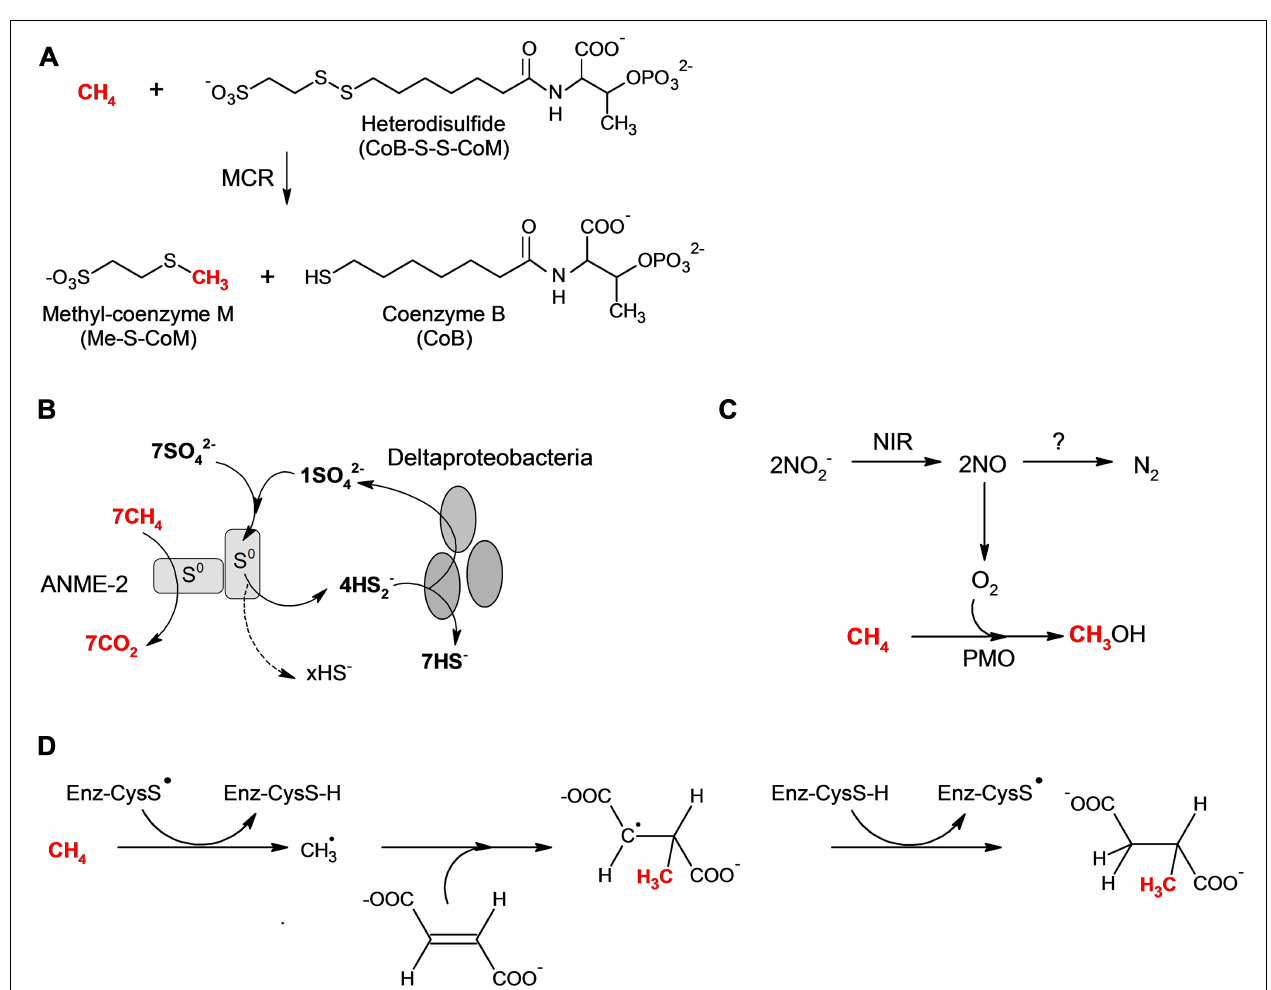
2010); and (D) Methane addition to fumarate (adapted from Beasley and Nanny, 2012). Enzyme nomenclature: methyl-coenzyme M reductase (MCR); nitrite reductase (NIR); particulate methane monooxygenase (PMO); and the putative thiyl radical of the alkylsuccinate/methylalkylsuccinate synthase-like enzyme